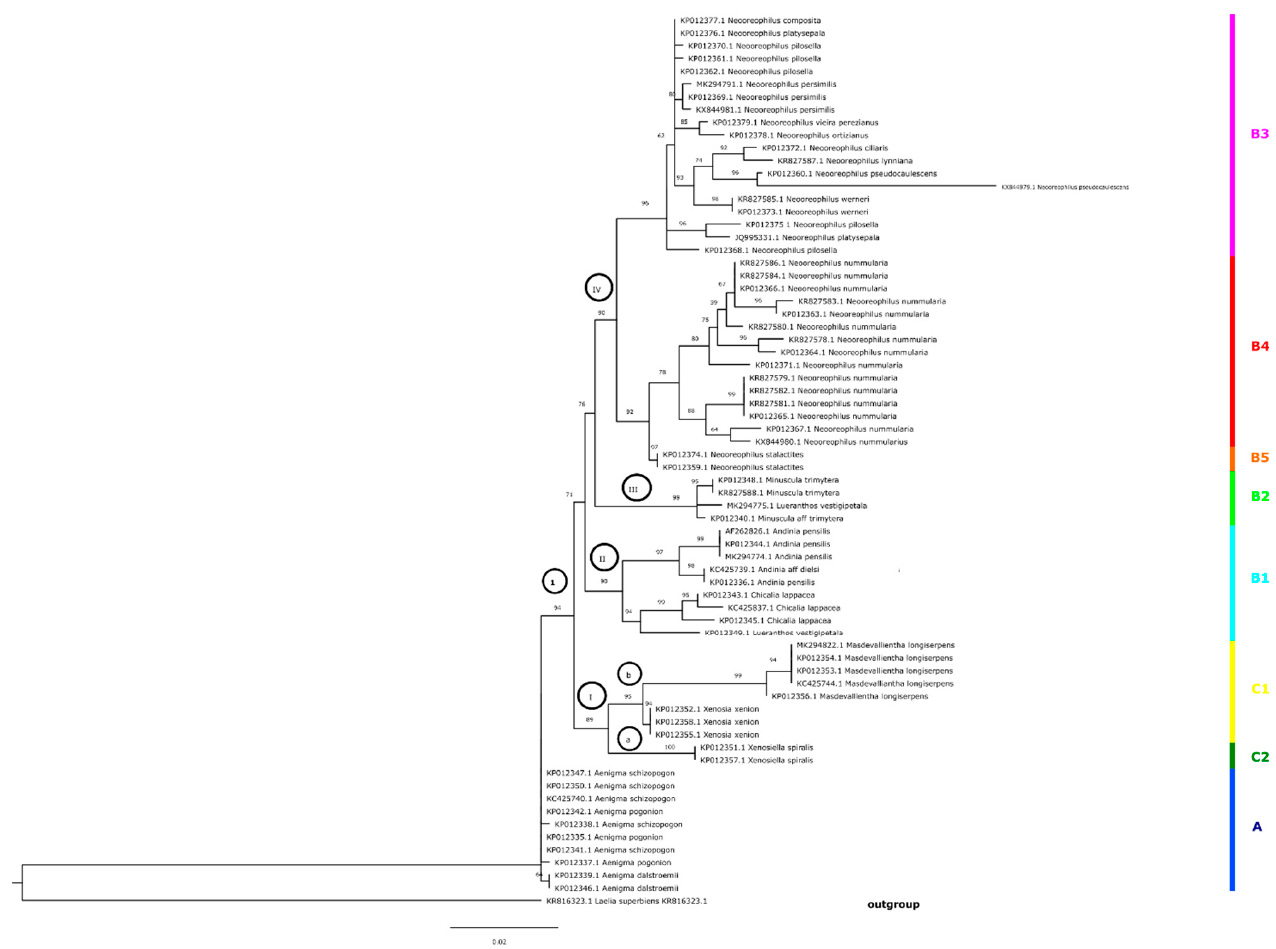
Figure 3. Phylogenetic tree performed based on maximum likelihood analysis inferred from the ITS matrix using ML/Transfer bootstrap expectation with 1000 bootstrap replicates in RaxML. Values at each node represent percent bootstrap support; bootstrap percentages less than 50% are not shown. The main and strong supported clades on the tree are marked with the numbers I–IV. However, the subclades are tagged as a and b. Discussed groups of species are marked as A–C2.